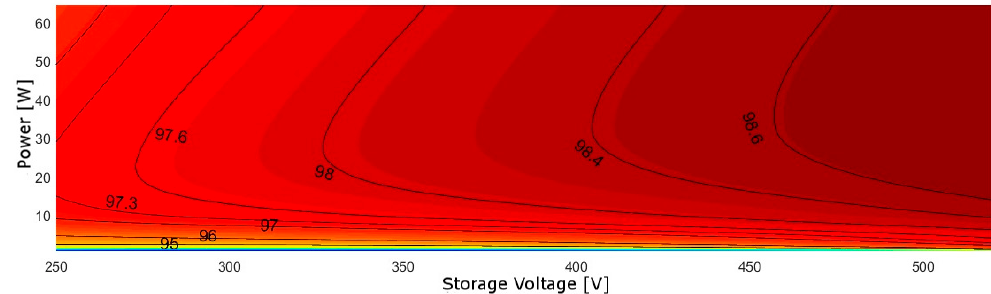
Figure 8. DC-DC Si converter efficiency [%].